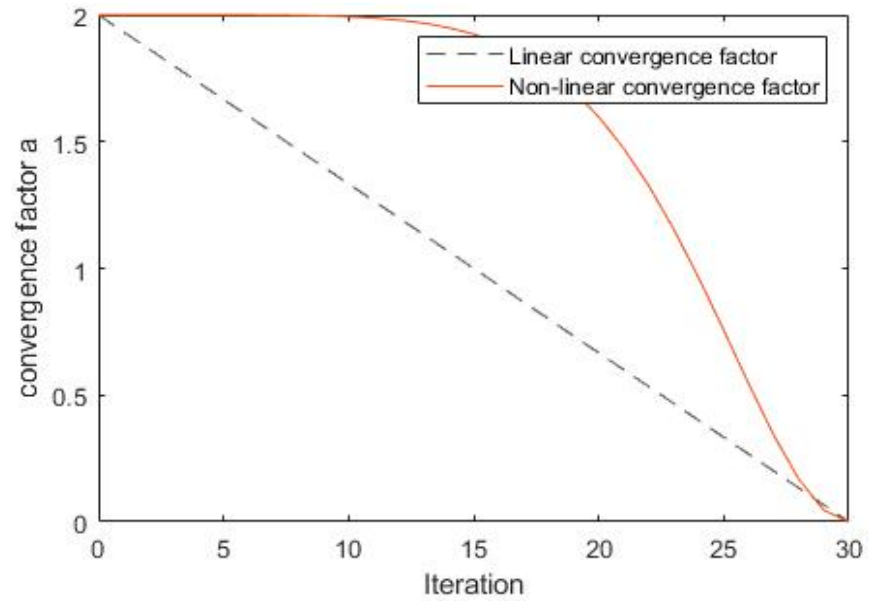
Figure 2. Two convergence factors.